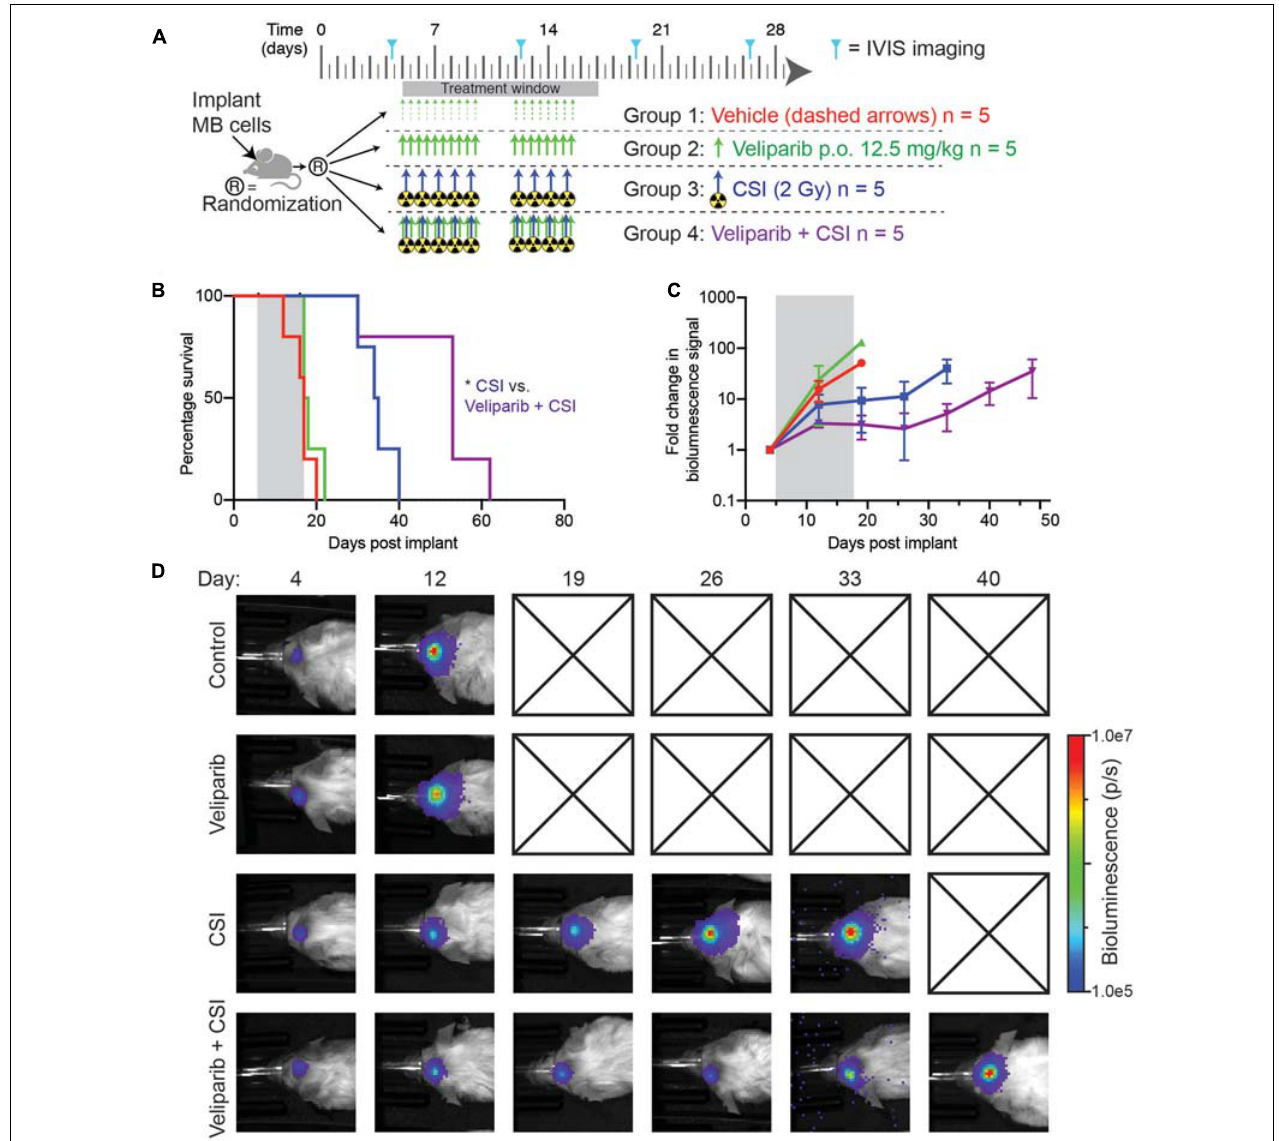
FIGURE 4 | Combination veliparib and CSI extends survival of mice with medulloblastoma. (A) Preclinical mouse treatment protocol for mice with orthotopic D425GiL Group 3 medulloblastoma for data shown in (B-D) , n = 5 mice per group. (B) Survival curves for mice treated as indicated in (A) . Mantel–Cox tests compared the combination-treated group with CSI alone: * p < 0.05. (C) Bioluminescence measurements from the animals shown in (B) . Data are represented as the fold change in mean ± SD bioluminescence flux measured over time with a representative mouse from each group shown in (D) . Checked boxes indicate that the animal was euthanized prior to the timepoint